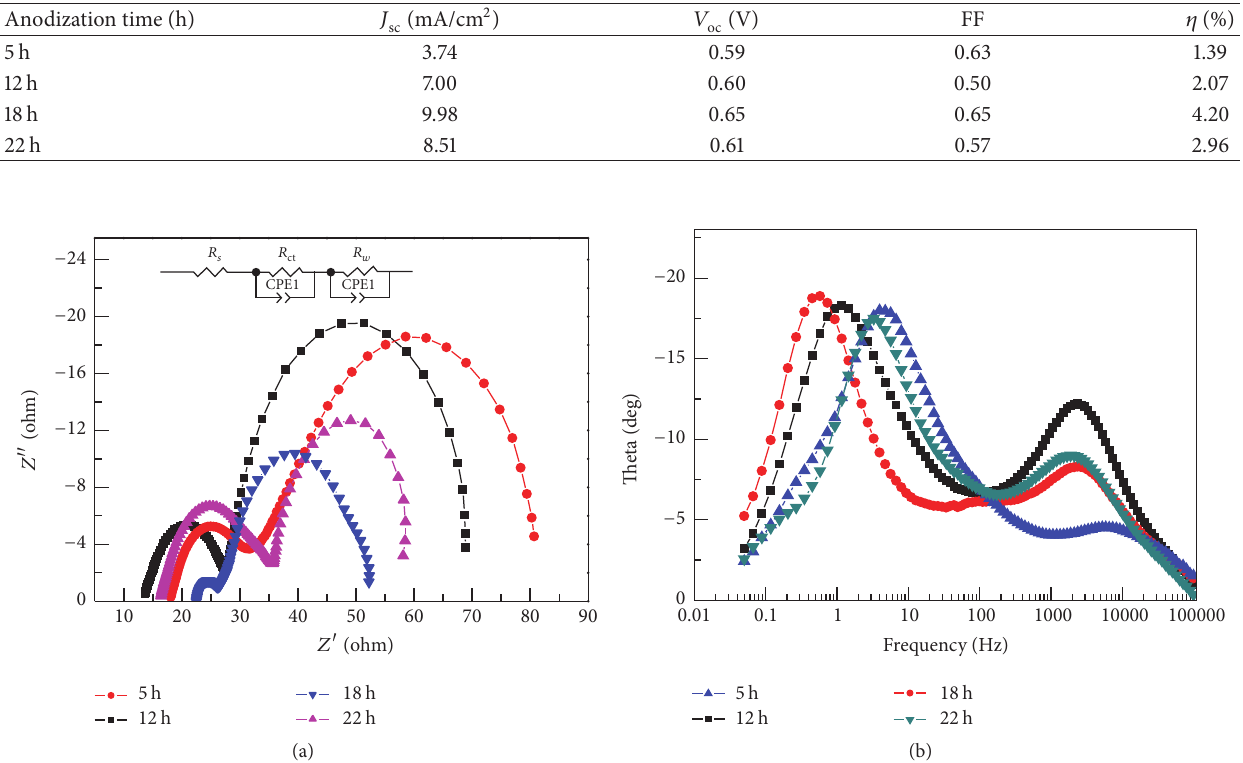
Figure 8: EIS spectra of the DSSCs based on P25/TNT arrays double-layer films with different anodization time. (a) Nyquist plots. (b) Bode phase plots.